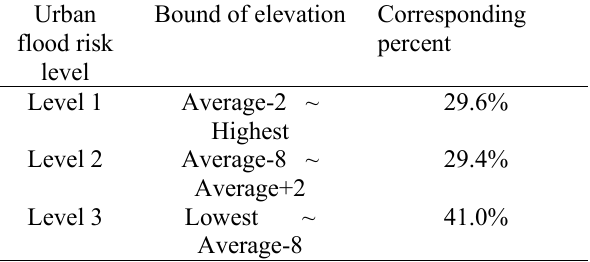
Table 1.Classification of elevation in flood risk.